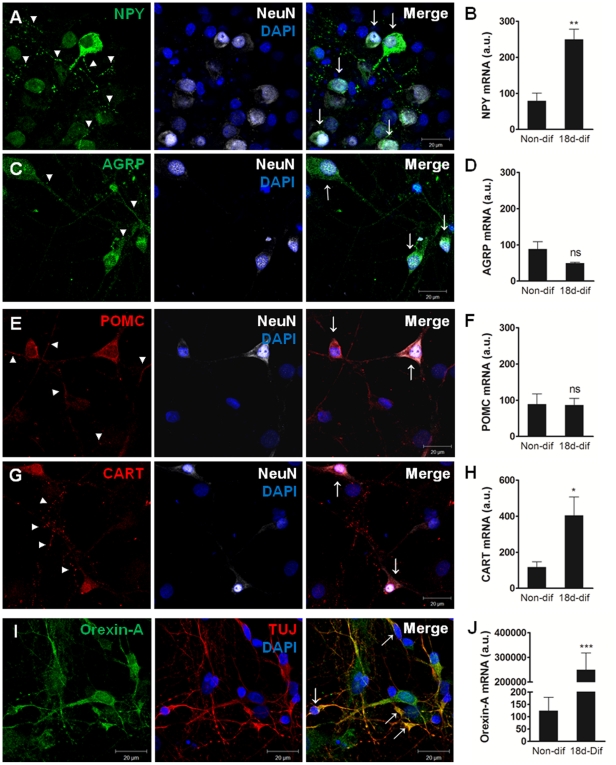
Hypothalamic neurospheres differentiate to mature neurons expressing appetite-related neuropeptides.Images of hypothalamic neurons cultures obtained from plated neurospheres after 18 days in differentiation conditions. NPY vesicular immunoreactivity (arrow-heads) (A) and NPY-positive neurons (arrows) (A-merge); AGRP vesicular immunoreactivity (arrow-heads) (C) and AGRP-positive neurons (arrows) (C-merge); POMC vesicular immunoreactivity (arrow-heads) (E) and POMC-positive neurons (arrows) (E-merge); CART vesicular immunoreactivity (arrow-heads) (G) and CART-positive neurons (arrows) (G-merge); Orexin-A immunoreactivity (I) and Orexin-A positive neurons (arrows) (I-merge). (B, D, F, H, J) Relative mRNA expression of feeding-related neuropeptides in hypothalamic neuronal cultures. The expression of NPY, CART and Orexin-A increases in differentiated hypothalamic cultures while the expression of AGRP and POMC is unchanged. Mean ± SEM. ns p>0.05, * p<0.05, ** p<0.01 and *** p<0.001, compared to non-differentiated hypothalamic neurospheres. n = 4/5; t-test. DAPI, nuclear staining; non-dif, non-differentiated hypothalamic neurospheres; 18d-dif, hypothalamic neurons culture after 18 days of differentiation.